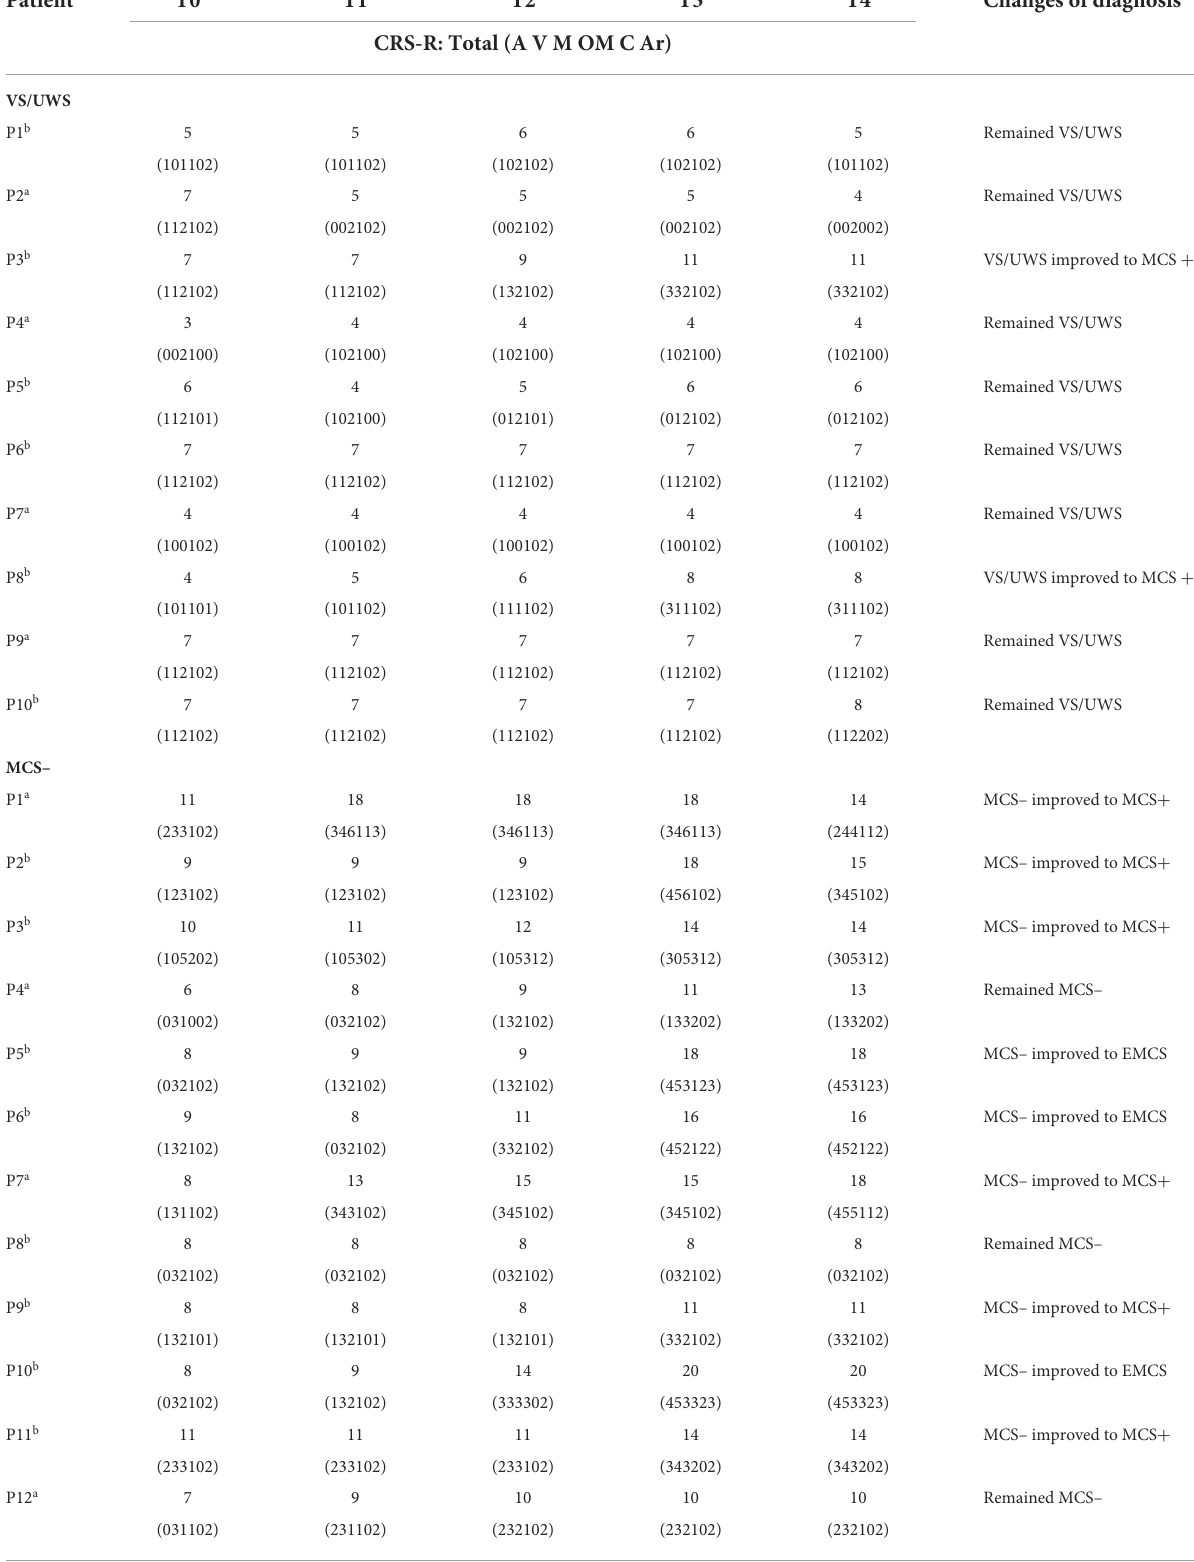
TABLE 2 Changes in CRS-R at different